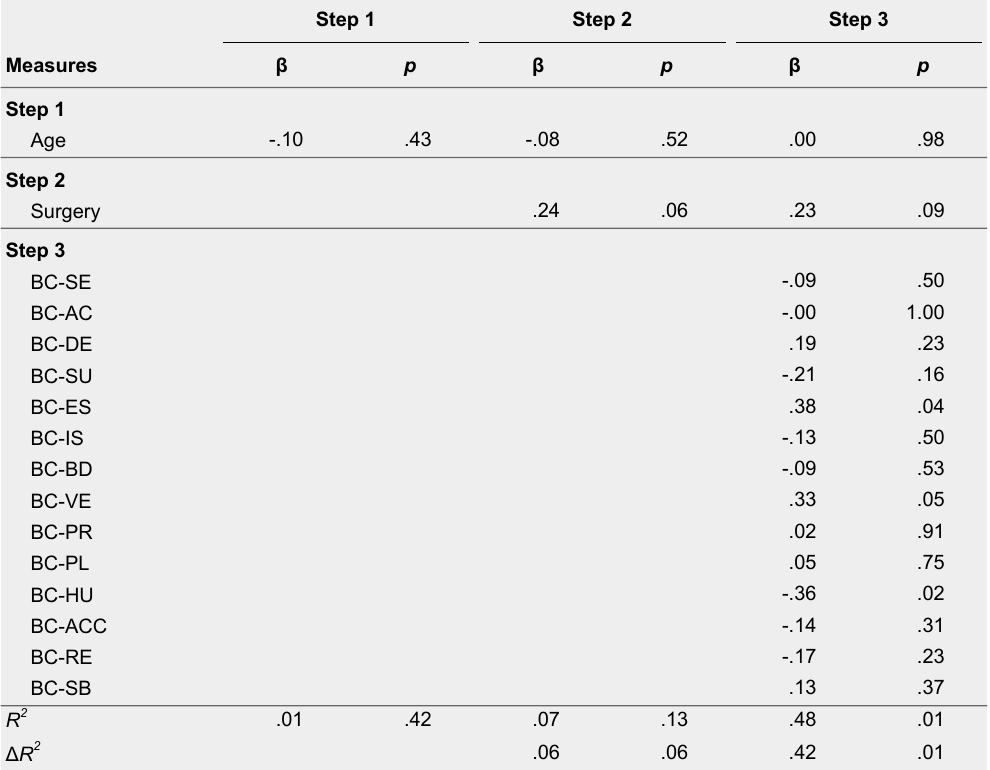
Hierarchical Multiple Regression of